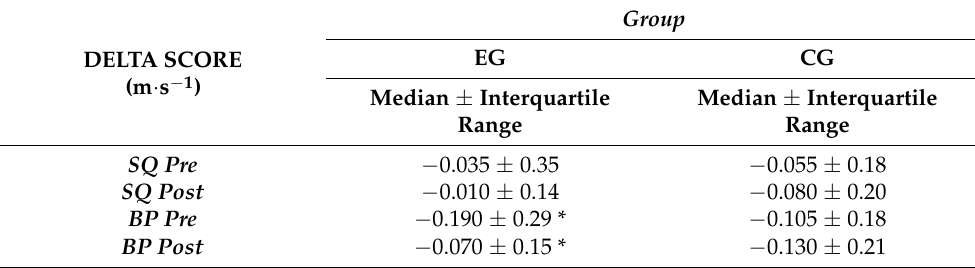
Table 5. Delta Score = Perceived velocity − Real velocity.